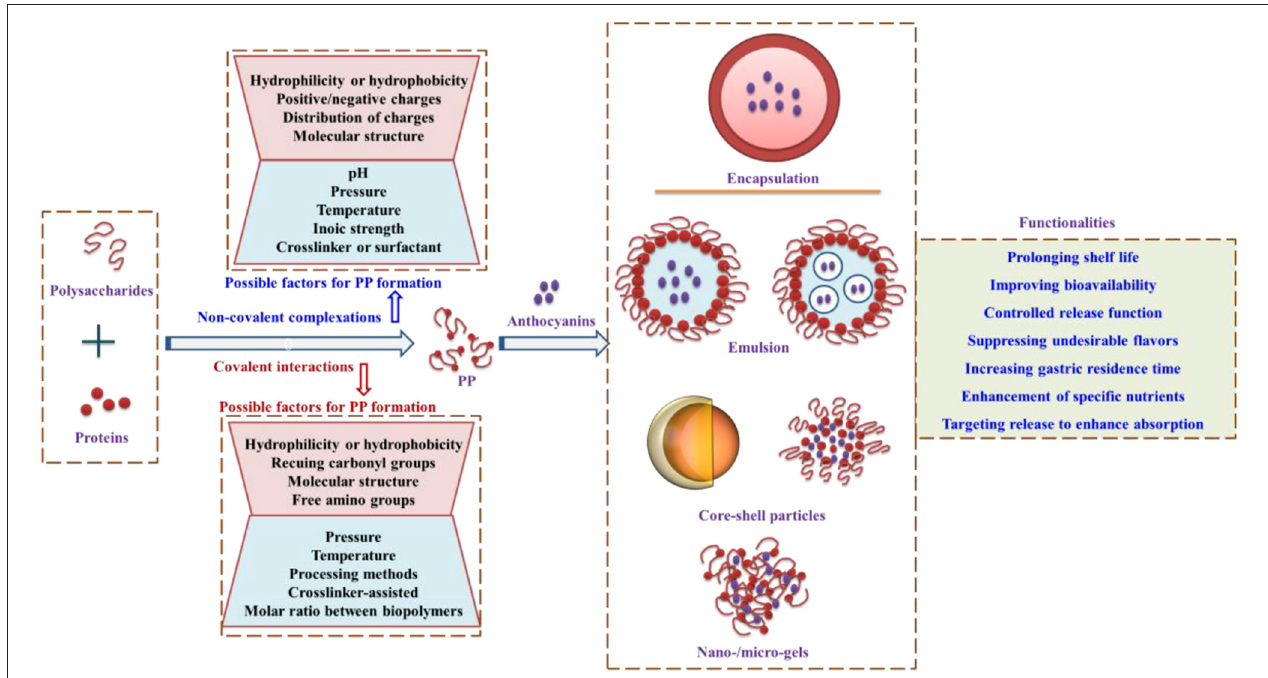
FIGURE 5 | Biopolymers formed by proteins and polysaccharides for anthocyanin encapsulation, the possible factors that affect biopolymer formation, and the functionality of encapsulation. PP, Protein–polysaccharides. Adapted from reference ( 57, 73, 76–78) with